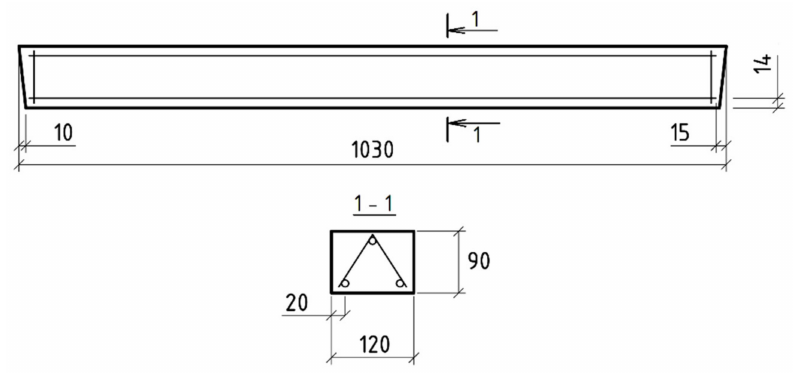
Figure 1. Geometric dimensions of lintel beams and the reinforcement